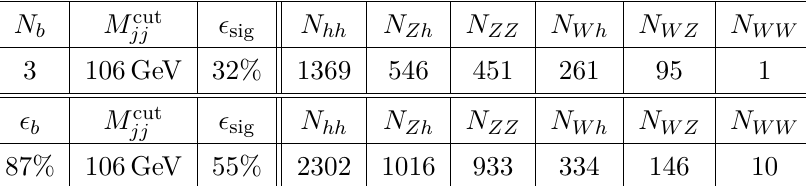
Table 9 . Top: optimal di-jet invariant mass cut and number of b -tags for E cm = 10 TeV, with (cid:15) b = 70% and ∆ M jj /M jj = 10% . Bottom: the same, but requiring N b = 4 and varying (cid:15) b